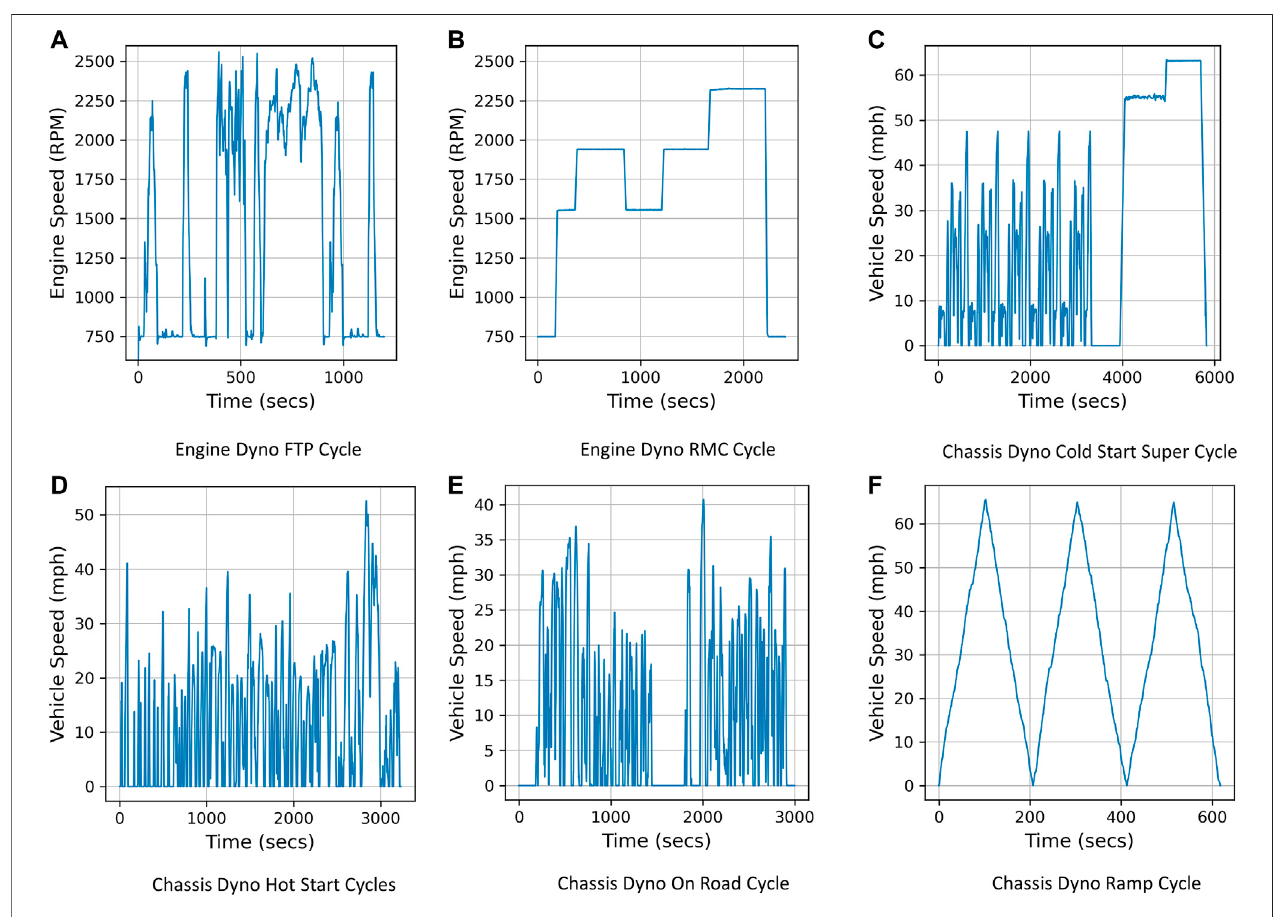
FIGURE 1 | Engine and Chassis dynamometer test cycles used to develop datasets for Deep Learning NO x Models. (A) Engine Dyno FTP Cycle. (B) Engine Dyno RMC Cycle. (C) Chassis Dyno Cold Start Super Cycle. (D) Chassis Dyno Hot Start Cycles. (E) Chassis Dyno On Road Cycle. (F) Chassis Dyno Ramp Cycle.